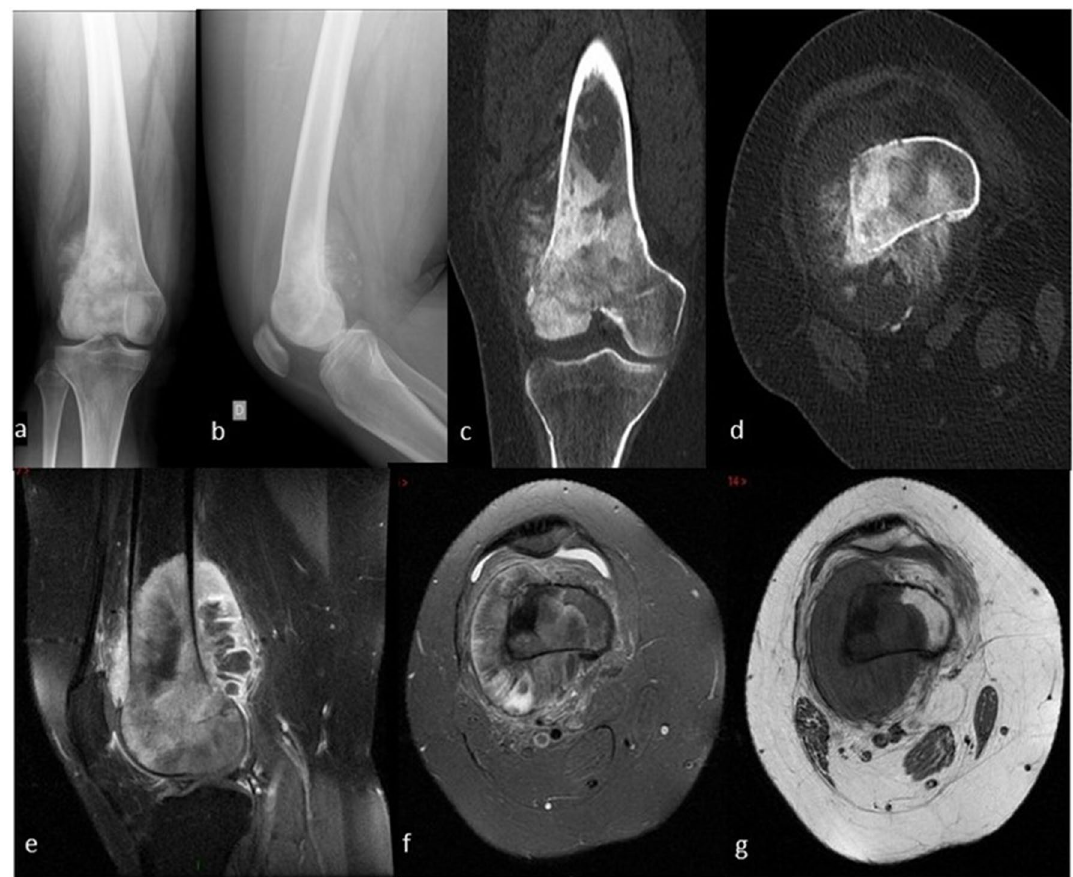
Figure 1. Case of osteosarcoma. A 25 year-old female, no smoker and no drinker, suffered of increasing daily inflammatory right knee pain in the last 6 months. Swelling was noticed few days ago. A tender swelling over the external part of the knee was palpable. Knee mobility was normal. ( 1a/b ) Anteroposterior and lateral radiographs of the knee. ( 1c/d ) Coronal and axial views on computed tomography. ( 1e/g ) T1 sagittal view, T2 fat suppressed axial and T1 sag fat suppressed axial views on magnetic resonance